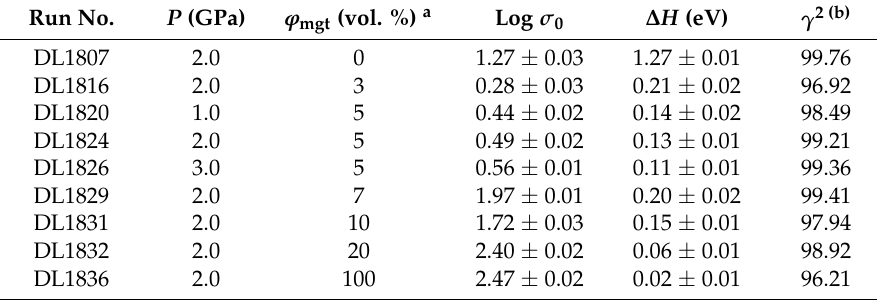
Table 1. Fitted parameters of the Arrhenius relation for the electrical conductivity of the magnetite-free and magnetite-bearing olivine aggregates at 1.0–3.0 GPa and 873–1273 K. Run No.